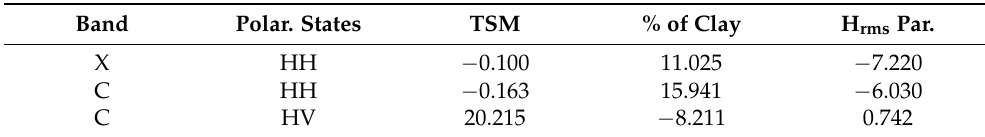
Table A2. Summary of the values of the multiple linear regression parameters for relationships obtained in the C-band in HV and VH polarization states considering the topsoil moisture, the fraction of clay, the standard deviation of roughness heights and the autocorrelation length collected in the direction parallel to the tillage orientation regarding the surface roughness. Band Polar. States TSM % of Clay H rms Par. X HH − 0.100 11.025 − 7.220 C HH − 0.163 15.941 − 6.030 C HV 20.215 − 8.211 0.742 The backscattering coefficients can be estimated using Equation (A2) and the parame- ters corresponding to the chosen satellite configuration.